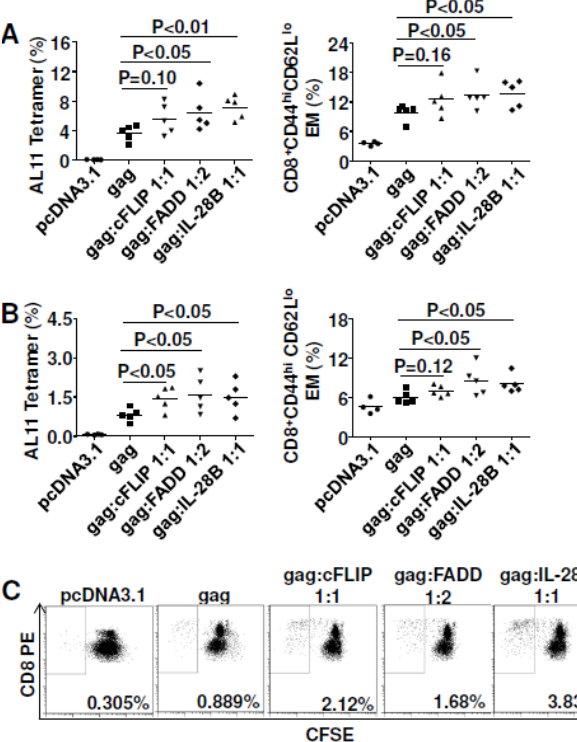
Figure 4. Fas-associated death domain (FADD) and IL-28B co-delivery improved cell- mediated immune (CMI) responses for SIVmac Gag. C57BL/6 mice were immunized with 2 μg plasmid pJ603-gag combined with 2 μg plasmid pJ603-cFLIP or plasmid IL-28B or 4 μg plasmid pJ603-FADD at day 0 and day 28. Mice were euthanized 10 ( A ) or 36 ( B and C